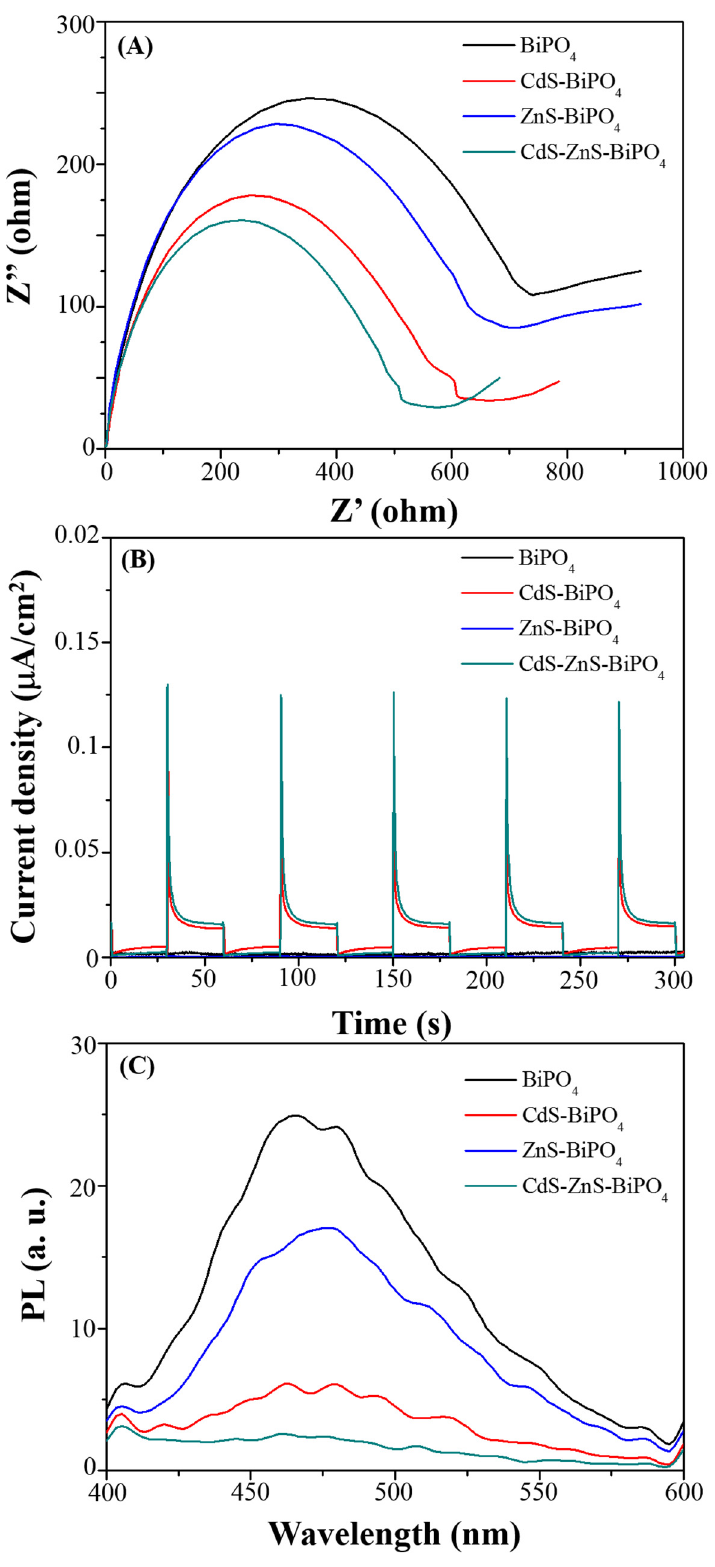
Figure 6. ( A ) EIS, ( B ) photocurrent, and ( C ) photoluminescence spectra of the BiPO 4 (black), CdS- BiPO 4 (red), ZnS-BiPO 4 (blue), and CdS-ZnS-BiPO 4 (olive) composites.